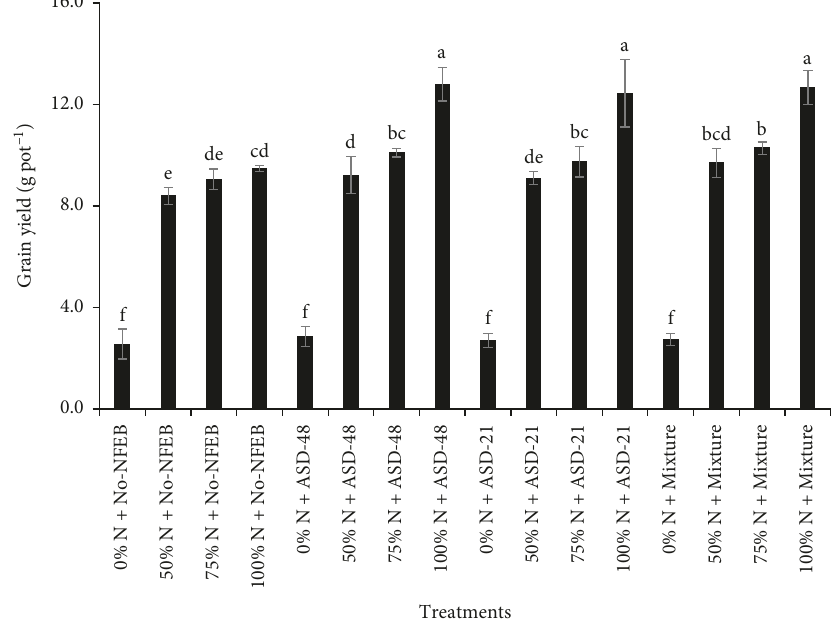
Figure 2: Effects of nitrogen fertilizer levels and nitrogen fixing endophytic bacteria supplementation, Enterobacter spp., on improvement of sesame yield cultivated on alluvial soil in